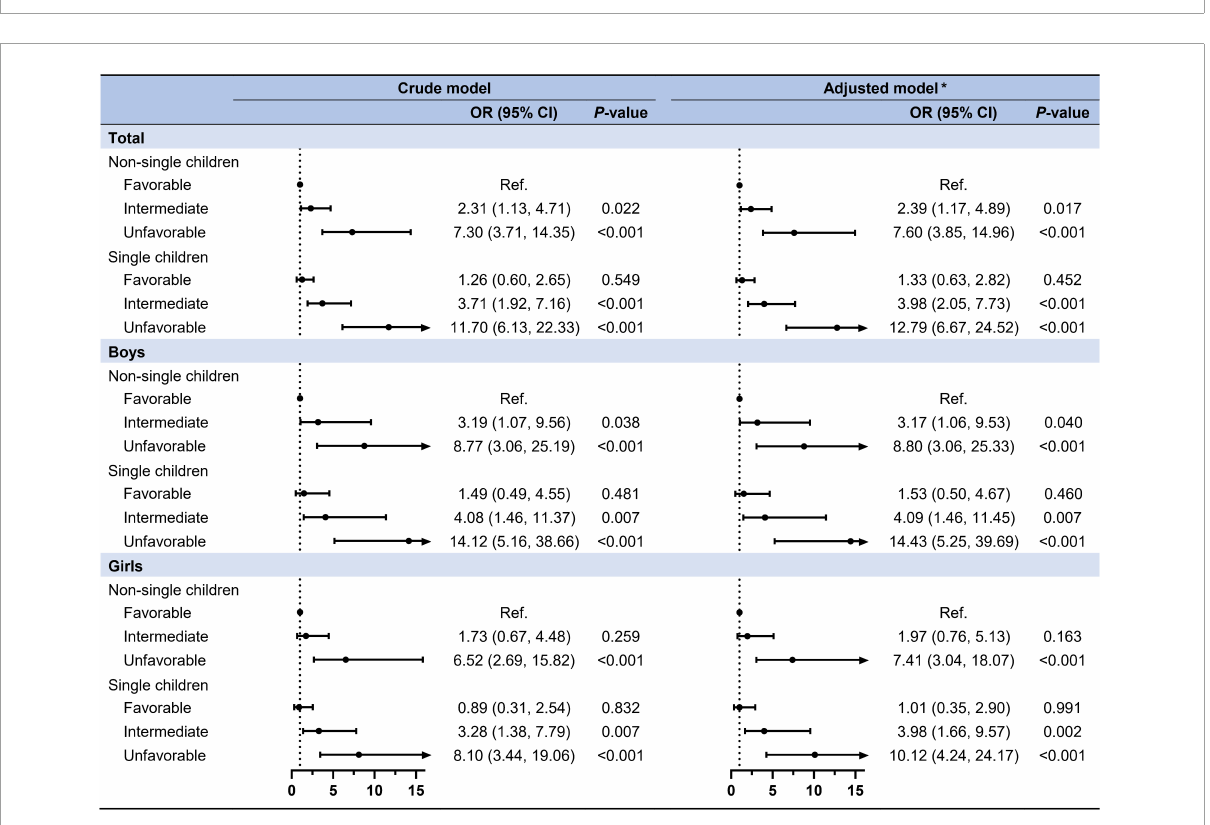
FIGURE4 The combined effect of single-child status and ideal lifestyle on clustered CMRFs. *Adjusted for age, residence, family history of diseases (obesity, hypertension, diabetes mellitus, and cerebrovascular disease), parental education level, parental tobacco, and alcohol consumption and the clustered effect of